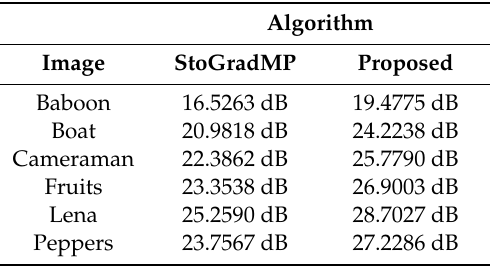
Table 1. Comparison of the average peak signal to noise ratios (PSNR) of the StoGradMP and proposed algorithms for the di ff erent test